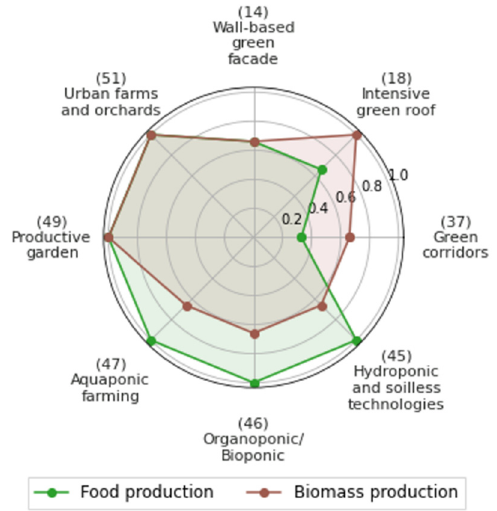
Figure 3. Evaluation for food and biomass production of nature-based agricultural solutions se- lected as urban agriculture representatives. Numbers of technological and spatial units (NBS_tu and NBS_su) corresponds to that given by Langergraber et al. [6] (cf. Table 2).